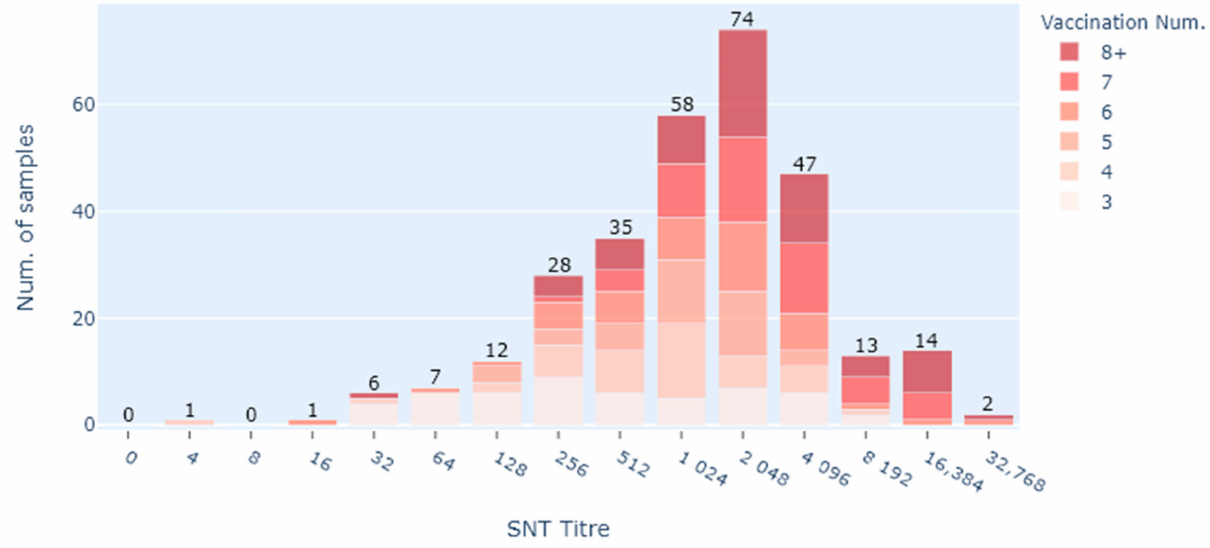
Figure 5. Stacked bar chart showing HeV serum antibody neutralising titres by the number of vaccinations that each horse has had at the time of sampling (3–8+); it does not include those that only had 1 or 2 vaccines ( n =